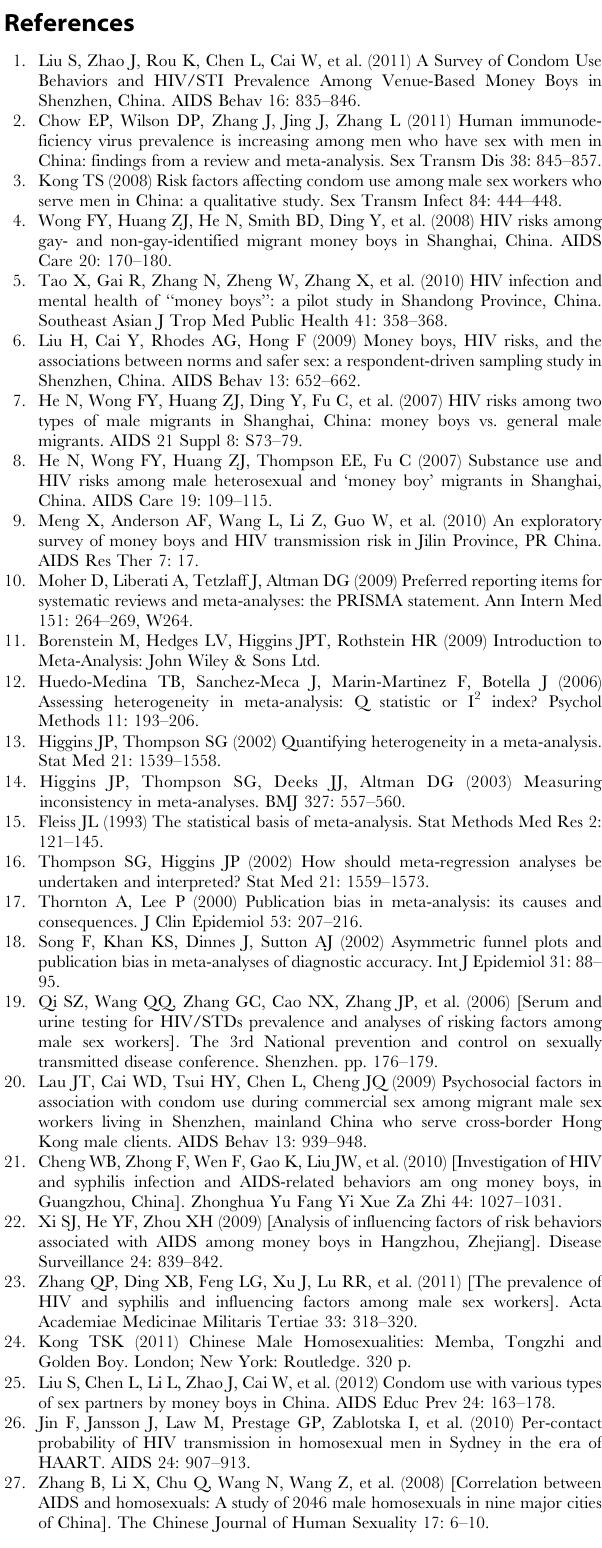
Table S4 Result of individual variable meta-regression models for each subgroup